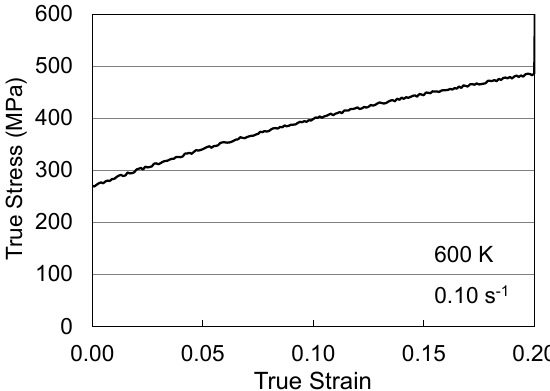
Figure 4. Stress–strain curve for the warm working operation in Follyalloy.